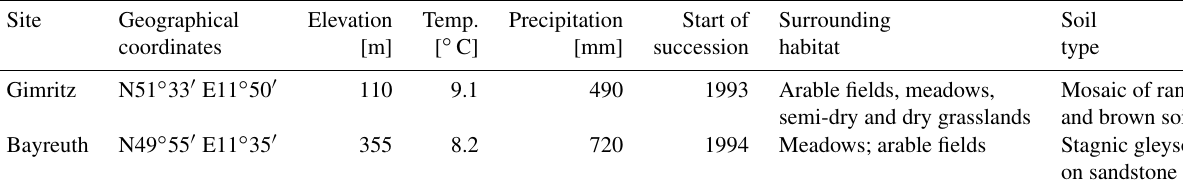
Table 1. Characteristics of the study sites Gimritz and Bayreuth: geographic coordinates, elevation above sea level, mean annual temperature (temp.), mean annual precipitation, year when the succession started, surrounding habitat and soil type according to the IUSS Working Group WRB (2007). All fields had been abandoned in spring.